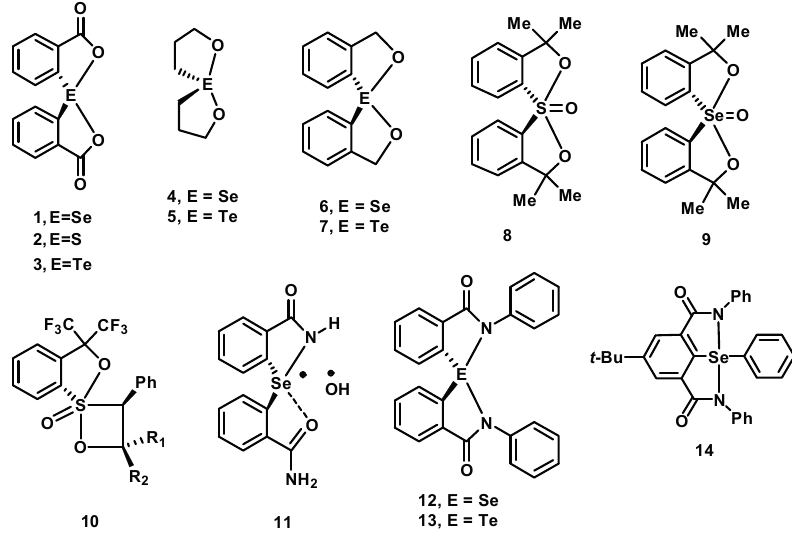
Figure 1. Some representative examples of stable